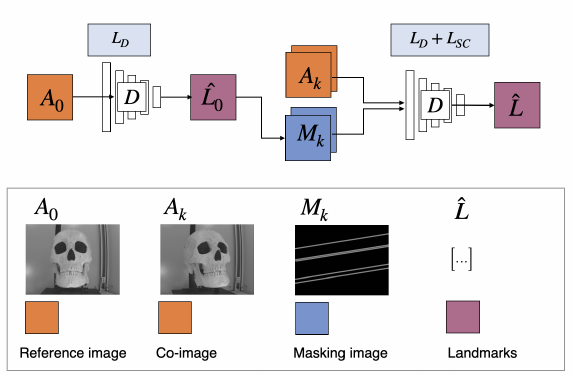
Figure 7. Overview of the proposed CLnet model: